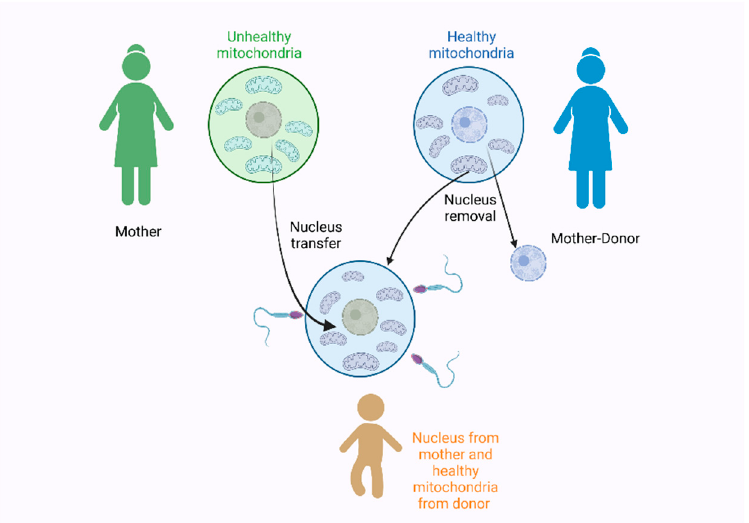
Figure 3. The three-parent technique used in 2016 by Zhang et al. [181] for the prevention of the Leigh syndrome during pregnancy. Figure created with Biorender.com.